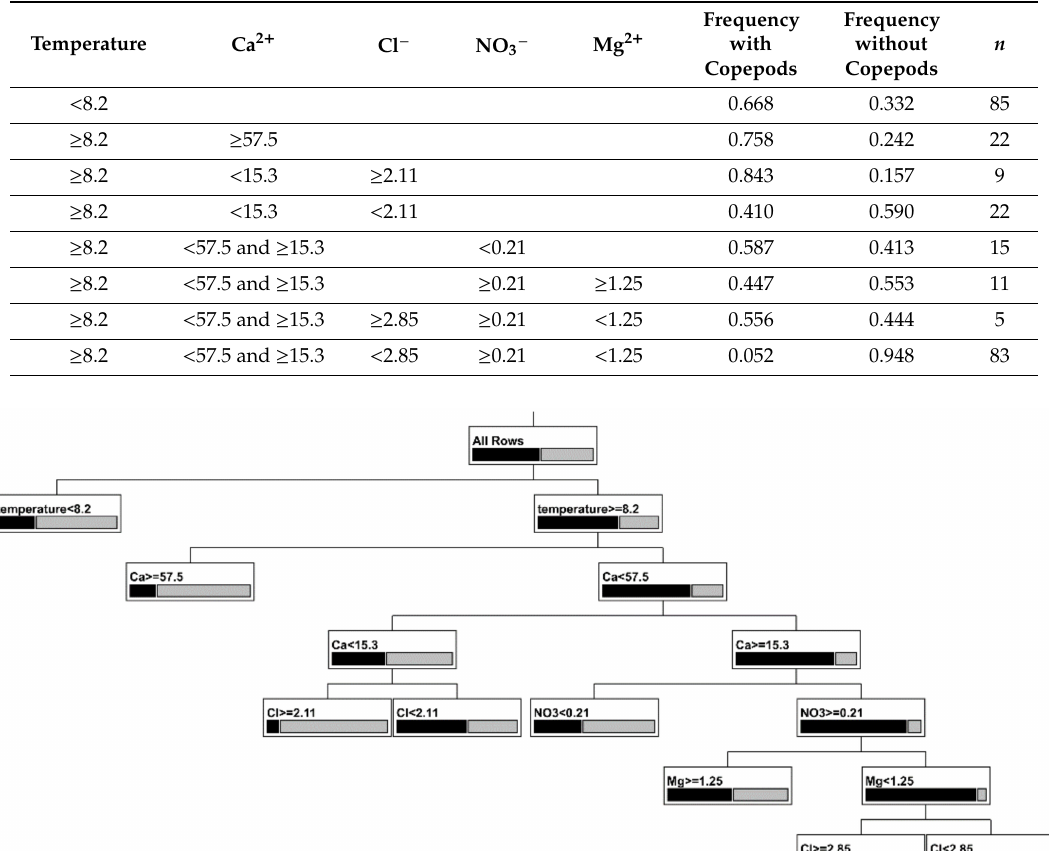
Table 6. Terminal “leafs” of classification tree (see Figure 5). Conductivity di ff erences were not in the optimal classification tree. Blanks indicate that no dichotomy for that variable exists for that leaf. Concentrations are in mg / L and temperature is in ◦ C.